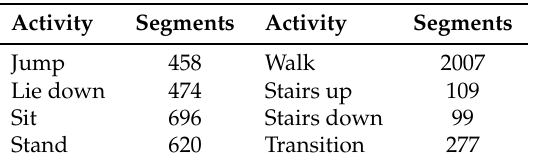
Table 4. Summary of the number of segments in each